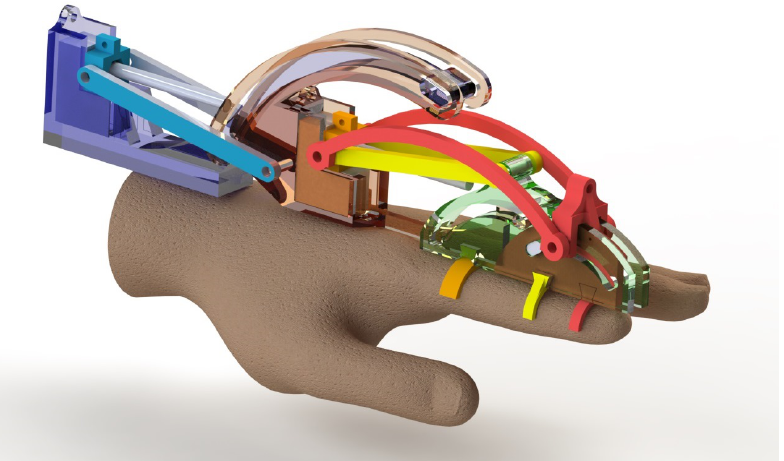
Figure 4. Mechanism’s 3D model for 2 DOF motion transmission of a human finger.